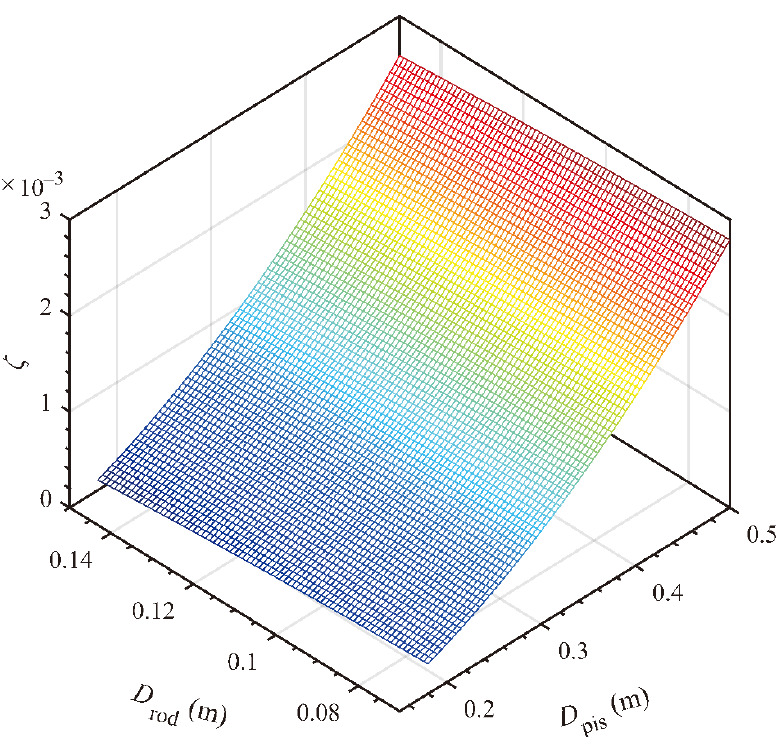
Figure 16. Effect of the piston diameter and rod diameter, D pis and D rod on the damping ratio, ζ .